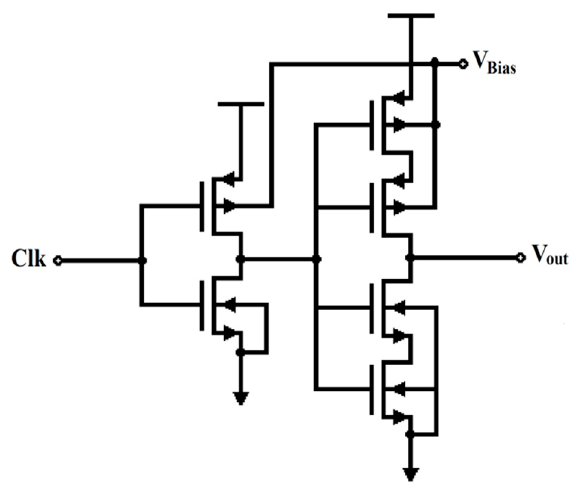
Figure 27. Delay unit for the second proposed ADC.